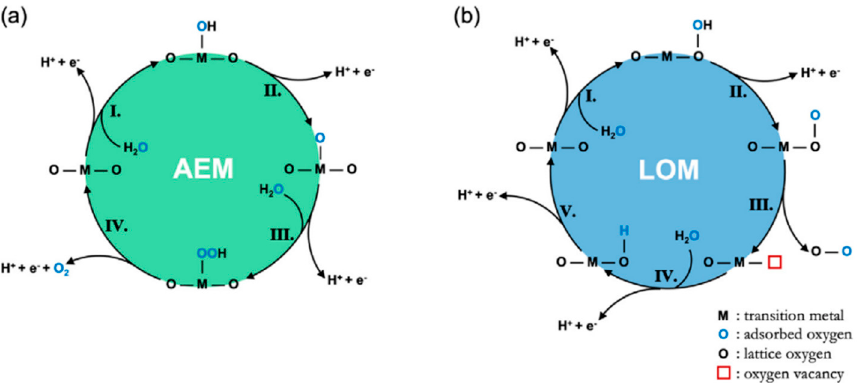
Figure 2. Diagrammatic sketch of ( a ) the AEM mechanism proposed by Rossmeisl et al. and ( b ) the LOER mechanism proposed by Rong et al. [24].